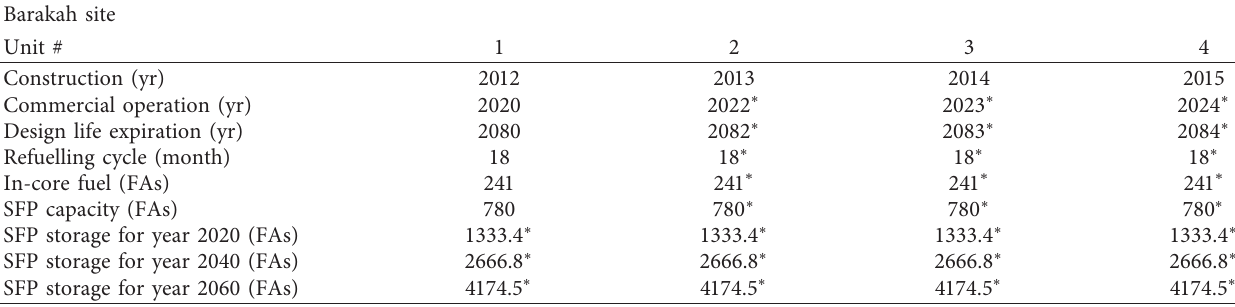
Table 3: Spent fuel generation status of Barakah